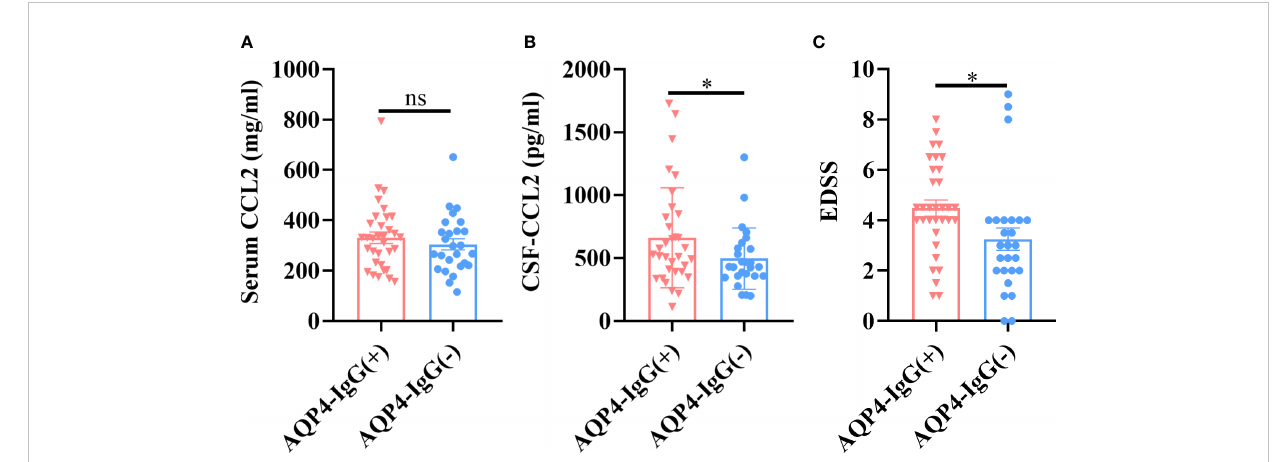
FIGURE 2 CCL2 levels in different NMOSD subgroups. AQP4-IgG-seropositive (AQP4-IgG+) ( n = 33) and AQP4-IgG-seronegative (AQP4-IgG – ) ( n = 26) subsets were further separated from the total NMOSD samples ( n = 59). (A) There were no signi fi cant differences in serum CCL2 levels between the two groups. (B) CSF CCL2 levels in the AQP4-IgG-seropositive group were signi fi cantly higher than in the AQP4-IgG-seronegative group. (C) Patients with AQP4-IgG-seropositive NMOSD had considerably higher EDSS scores than those with seronegative NMOSD. Data are presented as the mean ± SE. * p < 0.05, ns, not signi fi cant ( p >